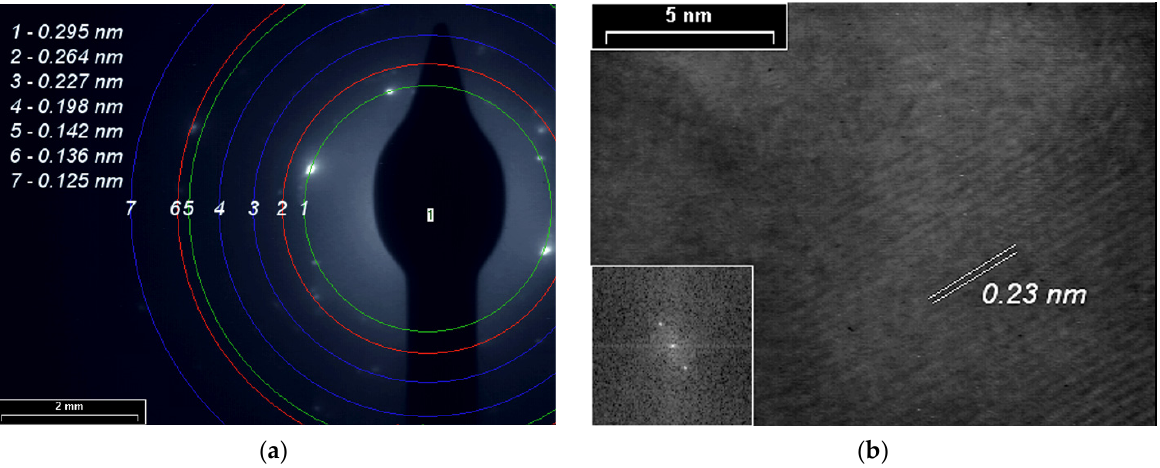
Figure 10. ( a ) SAED pattern; ( b ) HR-TEM images and in inset the fast Fourier transform (FFT) pat- tern of the PPAni-PDPA film. of the PPAni-PDPA